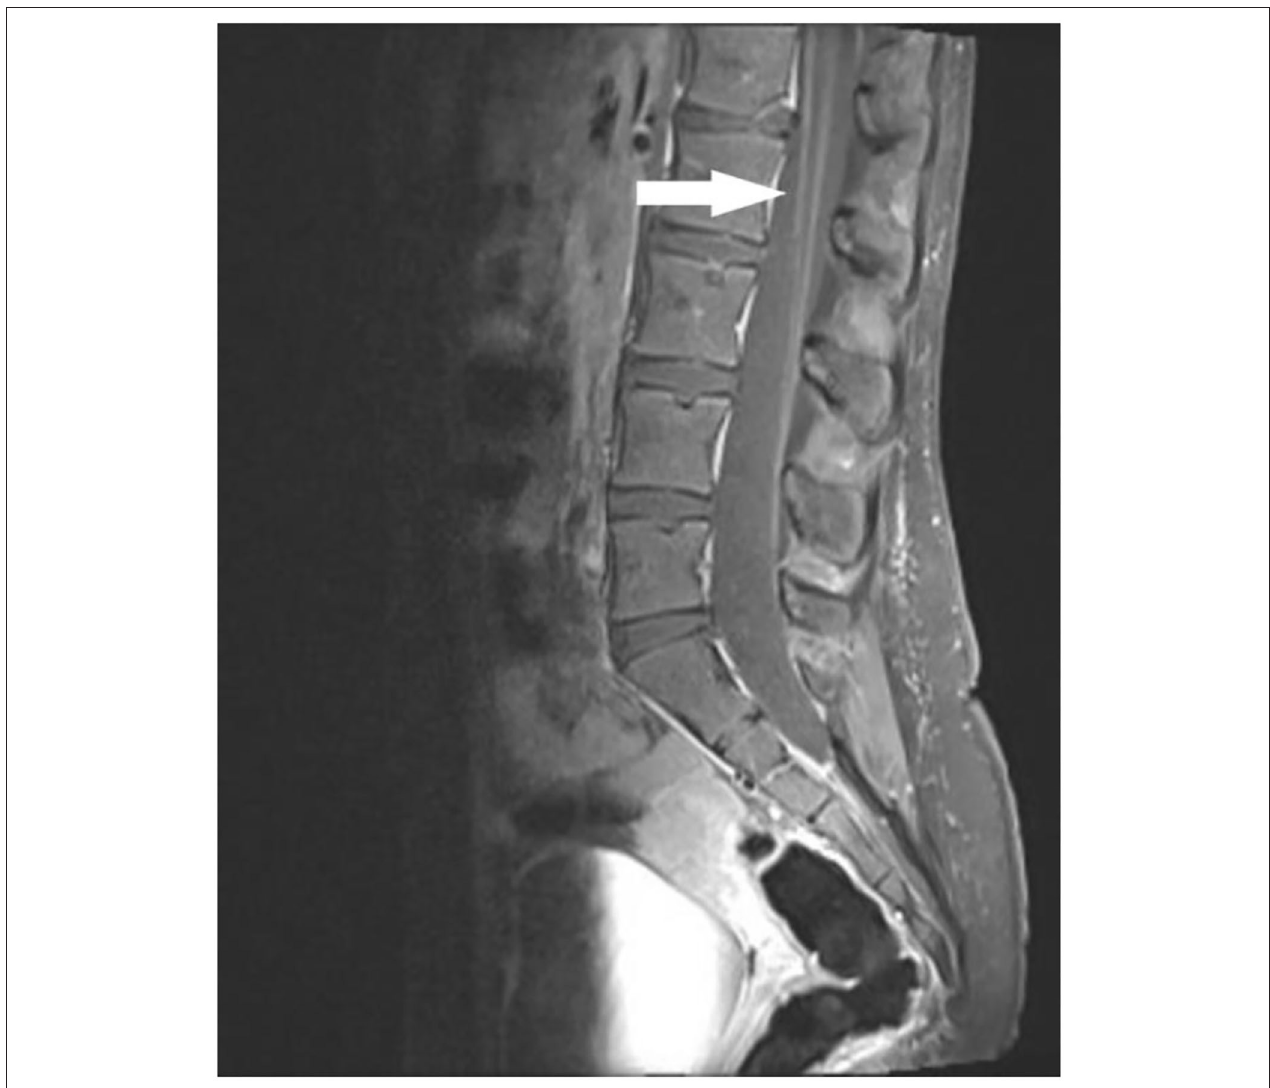
FIGURE 2 | Sagittal post-contrast T1 weighted MRI image of lumbo-sacral spine demonstrating cauda equina root enhancement